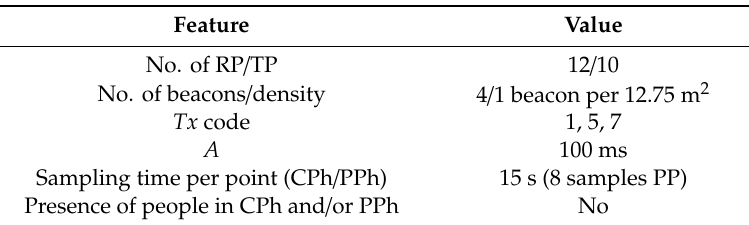
Table 5. Main features of Tests